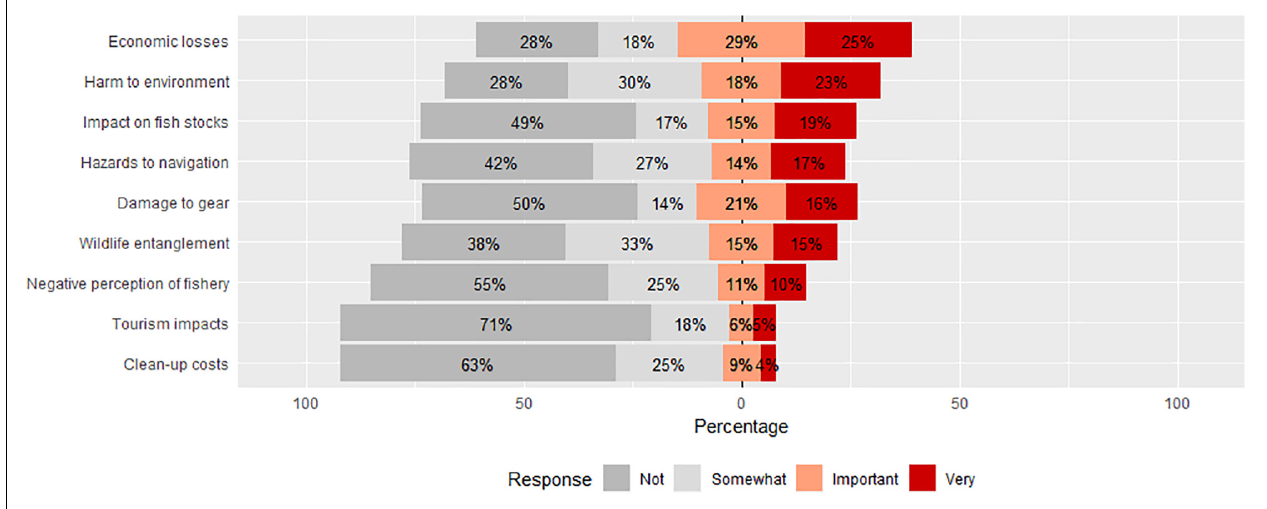
FIGURE 5 | Issues of concern around ALDFG to fishers across all gear types and countries combined. Low levels of concern are presented on the left side of the figure in dark to light grays, leading to higher concern levels as the reader moves right, and the colors warm from orange to salmon to red. Reading left to right, issues reported by fishers were ranked as “Not important,” “Somewhat important,” “Important,” and “Very important.” Total percentages are reported for each response and presented over the associated color